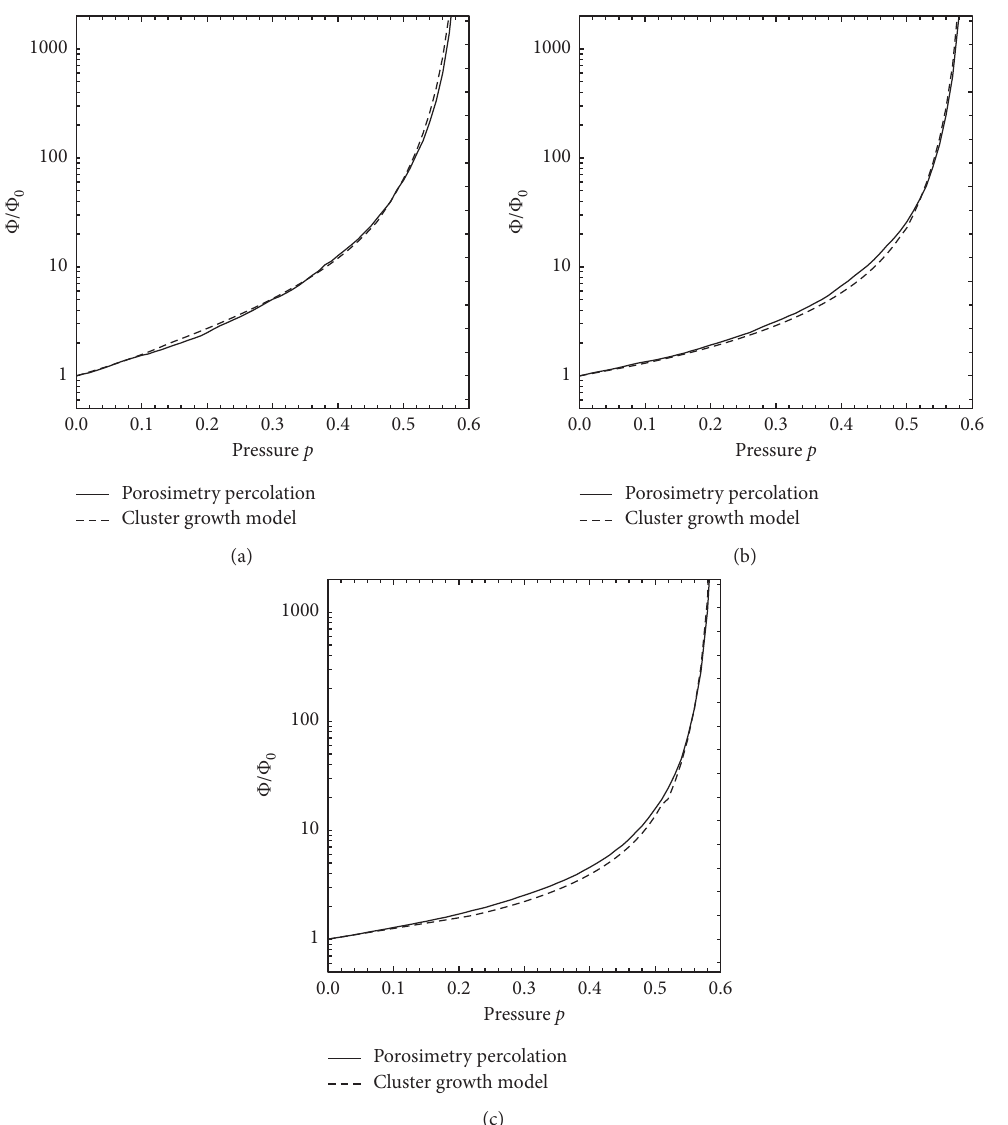
Figure 9: Φ scaled with the starting size Φ starting sets were (a) single site ( Φ � 7, I � ( Φ 0 0